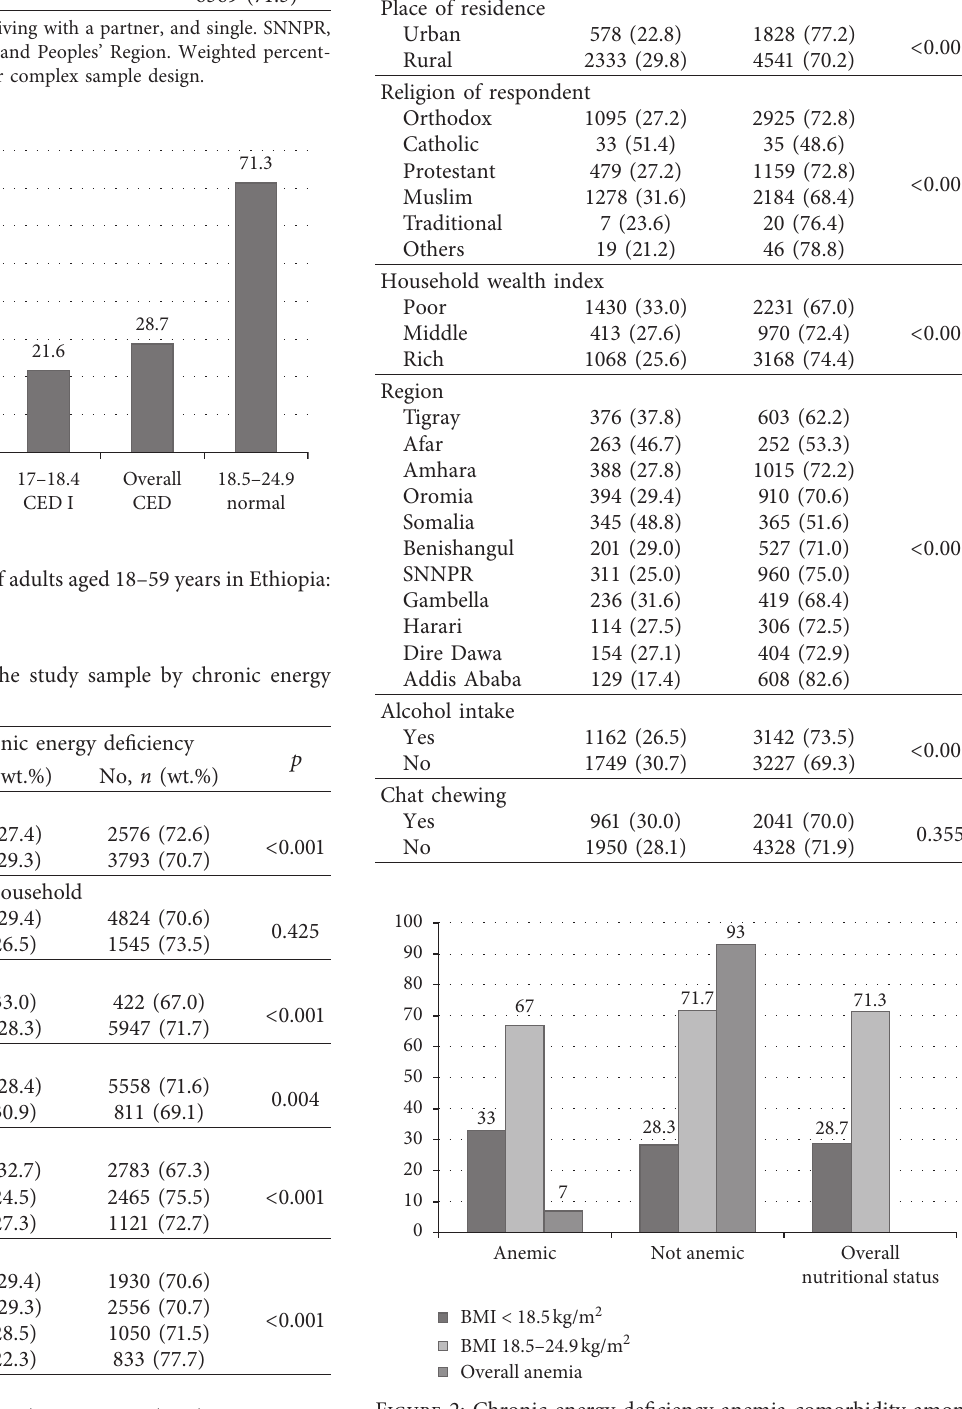
Figure 2: Chronic energy deficiency anemia comorbidity among adults aged 18–59 years old in Ethiopia: EDHS 2016 ( n �